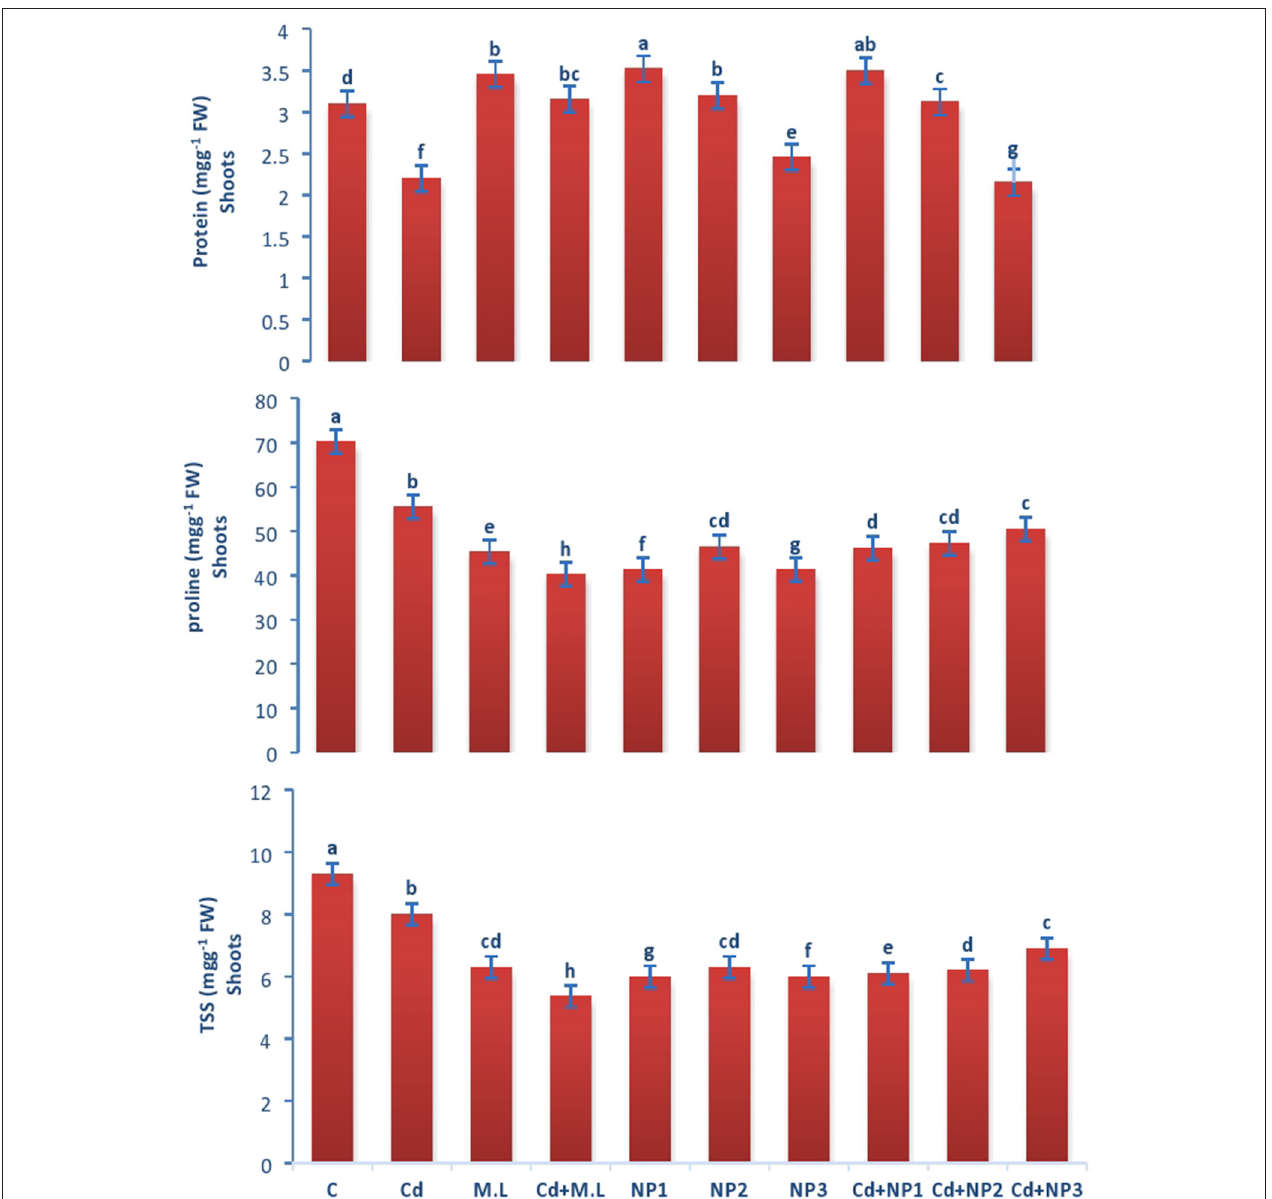
FIGURE 4 | Effects of MZnO–NPs on protein, proline, and TSS under Cd stress in Linseed shoots. Different letters indicate significant difference between the treatments. Data are means ± SE ( n = 5). Non-identical letters specify significant difference at P ≤ 0.05. C, Control; Cd, 100mg kg − 1 Cd; M. L, Moringa